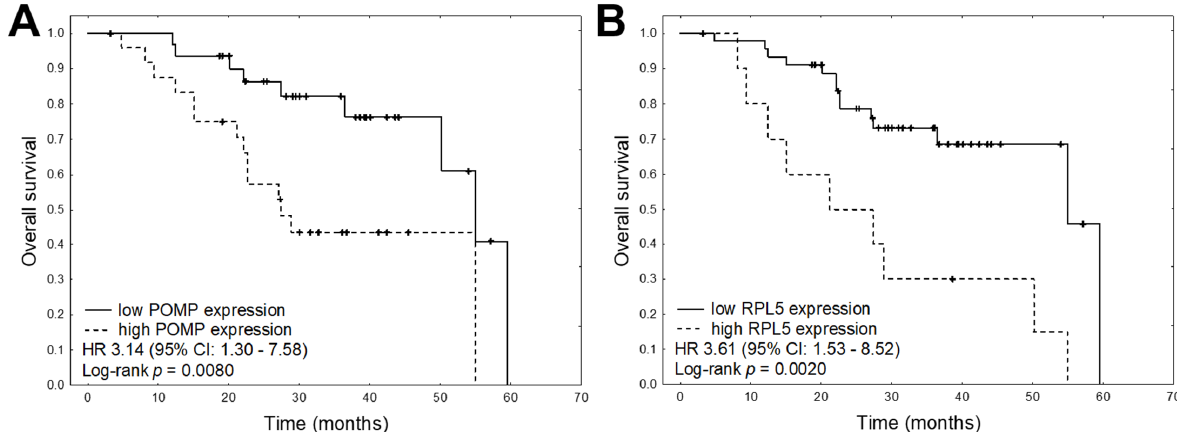
Figure 4. Kaplan–Meier plots for each of the significant mRNAs in the univariate analyses for OS: ( A ) POMP , ( B ) RPL5.